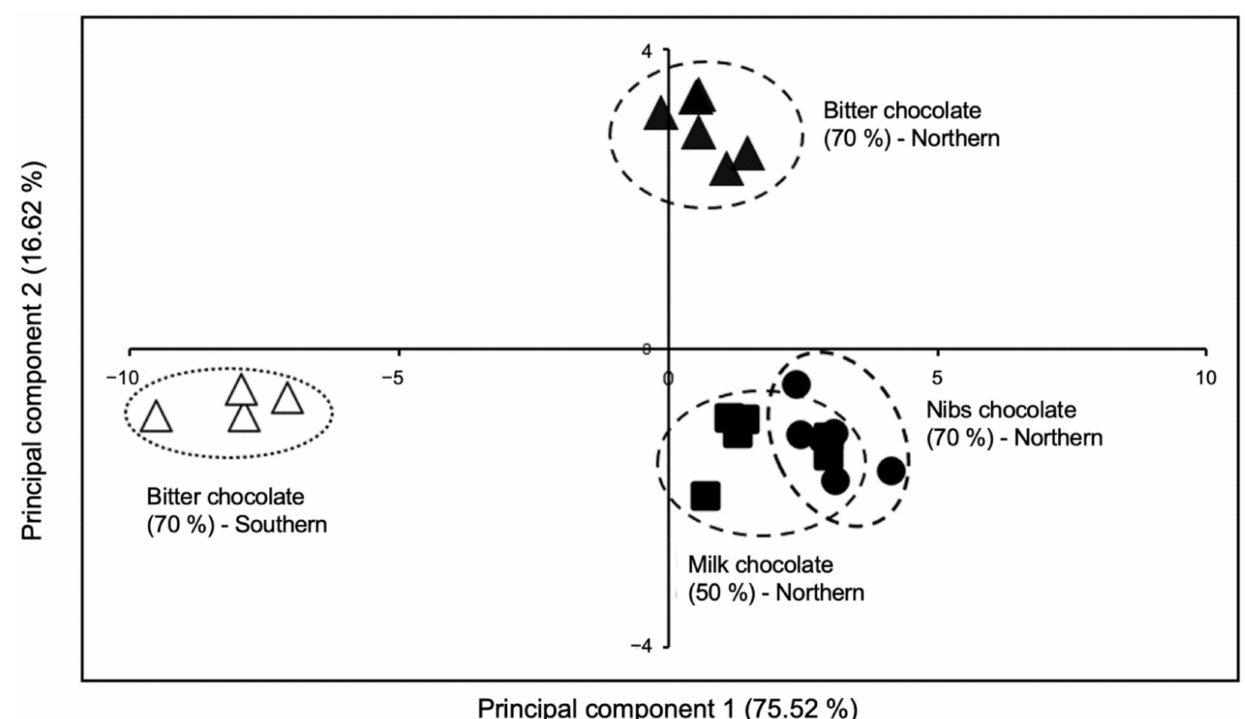
Figure 1. Principal component analysis of chocolates from northern and southern Peru. By reducing the focus from 93 to 11 VOCs (shown in Tables 1 and 2, respectively), it is possible to diminish the measurement errors associated with reproducibly monitoring multiple VOCs in food samples [58]. Due to the limited availability of standards, a tandem MS strategy was used for their identification. Thus, the identity of three of them could be validated by their fragmentation pattern measured by a third-party lab using a GC-MS/MS Trace 1300 instrument, Thermo Scientific (MS NIST 2011 Spectral Library). Likewise, since the measured samples are from a known biological origin (i.e., FFC species), peer-reviewed publications of cocoa VOCs were also used to putative identify the metabolites in Table